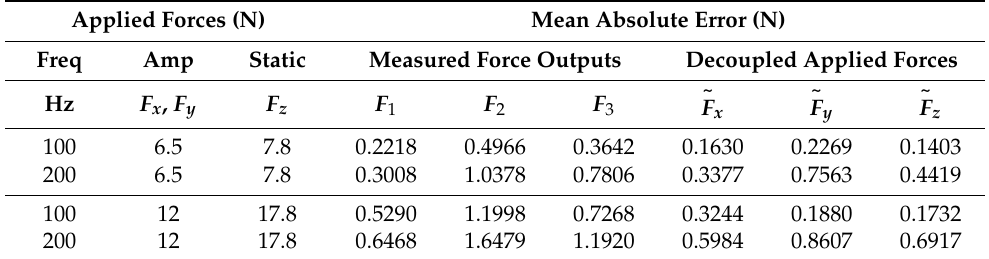
Table 3. Dynamic loading test result comparison and effect due to variation in excitation fre- quency.